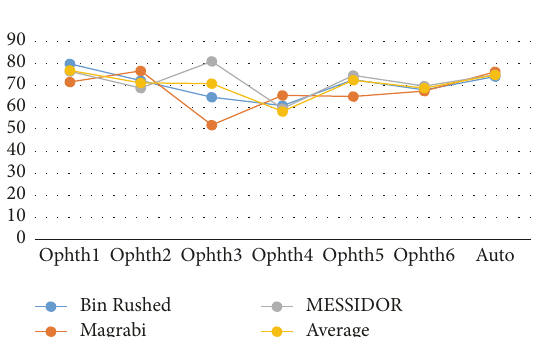
Figure 6: The number of images agreed for the HCDR between the ophthalmologists and the algorithm. 𝑥 -axis represents the number of 6 ophthalmologists and the algorithm. 𝑦 -axis represents the number of agreed